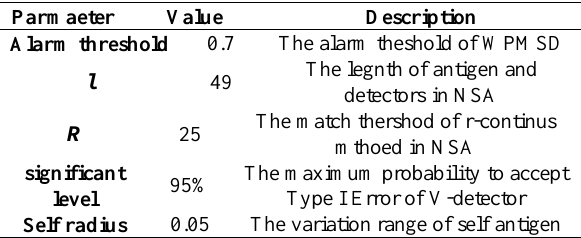
Table 1. The parameters set.